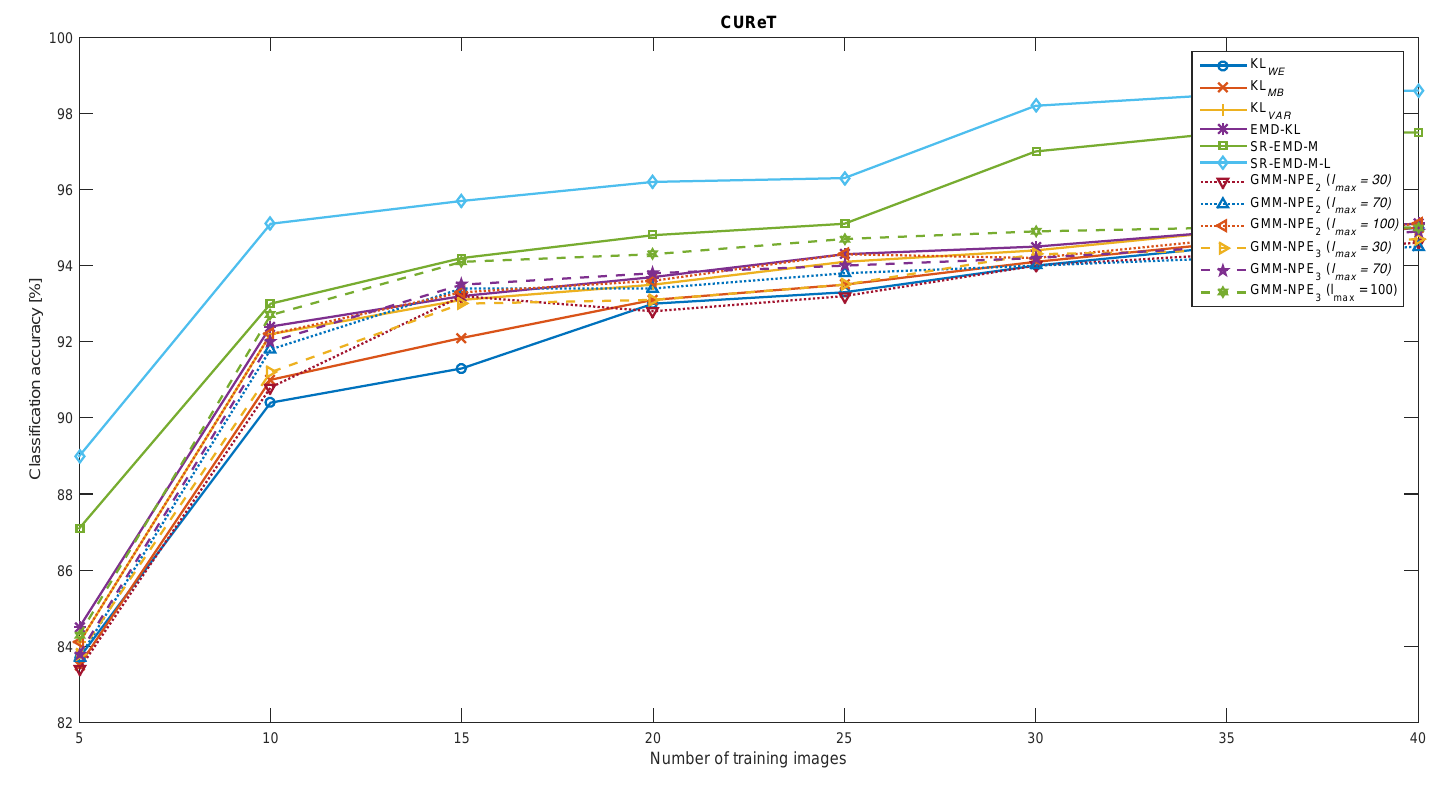
Figure 2. Classification rate vs. the number of training examples for the CUReT texture database for the proposed method in comparison to baseline